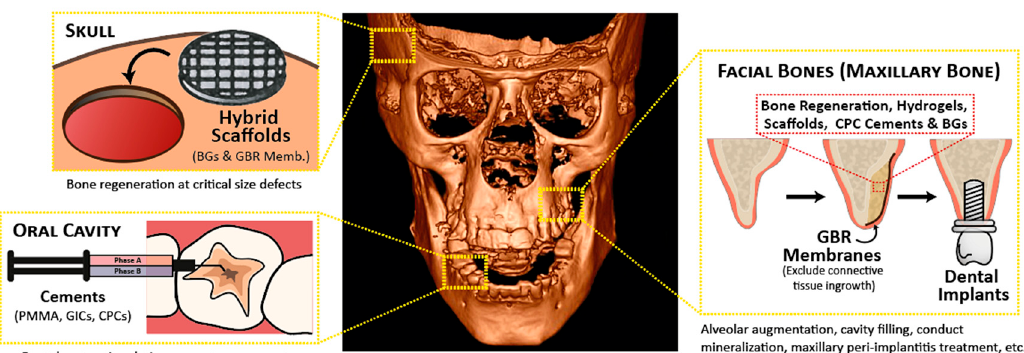
Figure 1. Most clinically applied systems in oro-cranio-facial regeneration and areas of interest, including the skull, facial bones (e.g., maxillary bone), and the oral cavity. Applications are shown below the boxes. Abbreviations: Bioactive glasses (BGs), calcium phosphate cements (CPCs) glass ionomer cements (GICs), guided bone regeneration membranes (GBR Memb.), polymethyl methacrylate cements (PMMA).